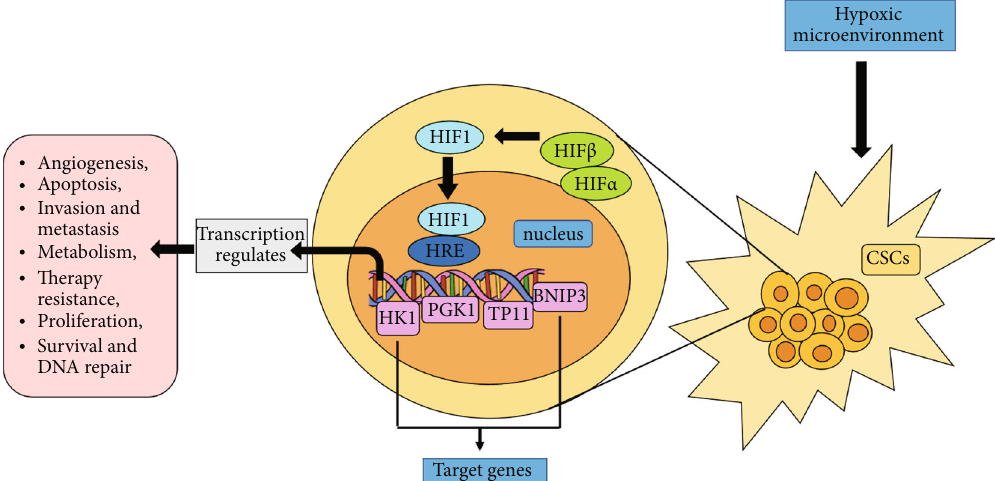
Figure 4: Role of HIFs in CSCs. Under hypoxia, HIF-1 is formed after the dimerization of HIF-1 α with HIF-1 β and binds to the HRE (HIF- responsive element) present at the DNA. This binding results in the transcription of the targeted genes (HK1, PGK1, TP11, and BNIP3) (depicted in pink boxes) and regulates the various cellular processes like survival, angiogenesis, apoptosis, invasion, metastasis, metabolism, therapeutic resistance, and DNA